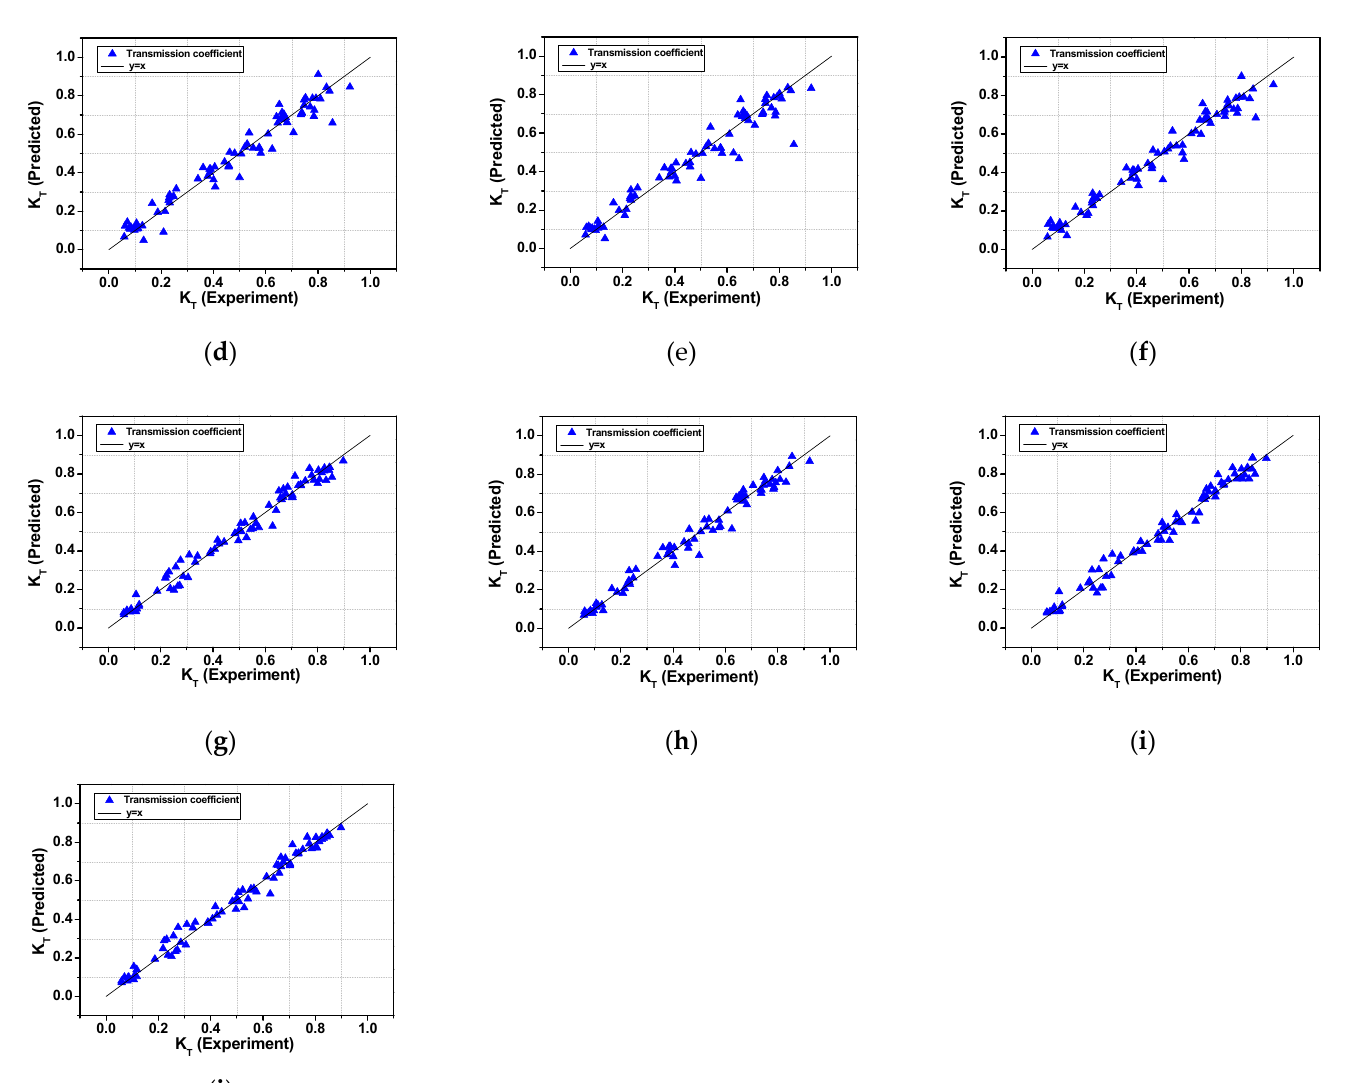
Figure A1. Measured versus predicted values for the various models. ( a ) Linear; ( b ) Ridge; ( c ) Lasso; ( d ) KR; ( e ) GPR; ( f ): SVM; ( g ) RF; ( h ) ANN; ( i ) AdaBoost; ( j ) Gradient boost.